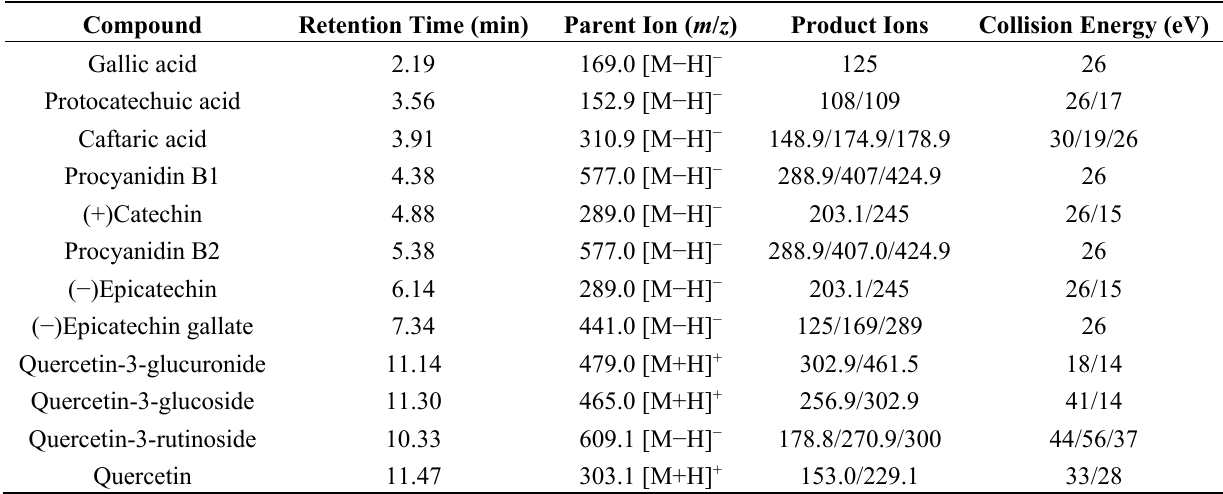
Table 1. LC-MS/MS analytical